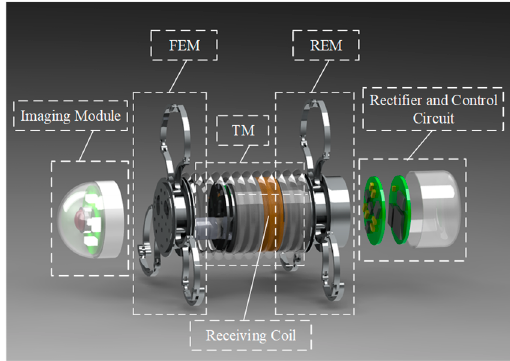
Figure 1. The structure of robot system.